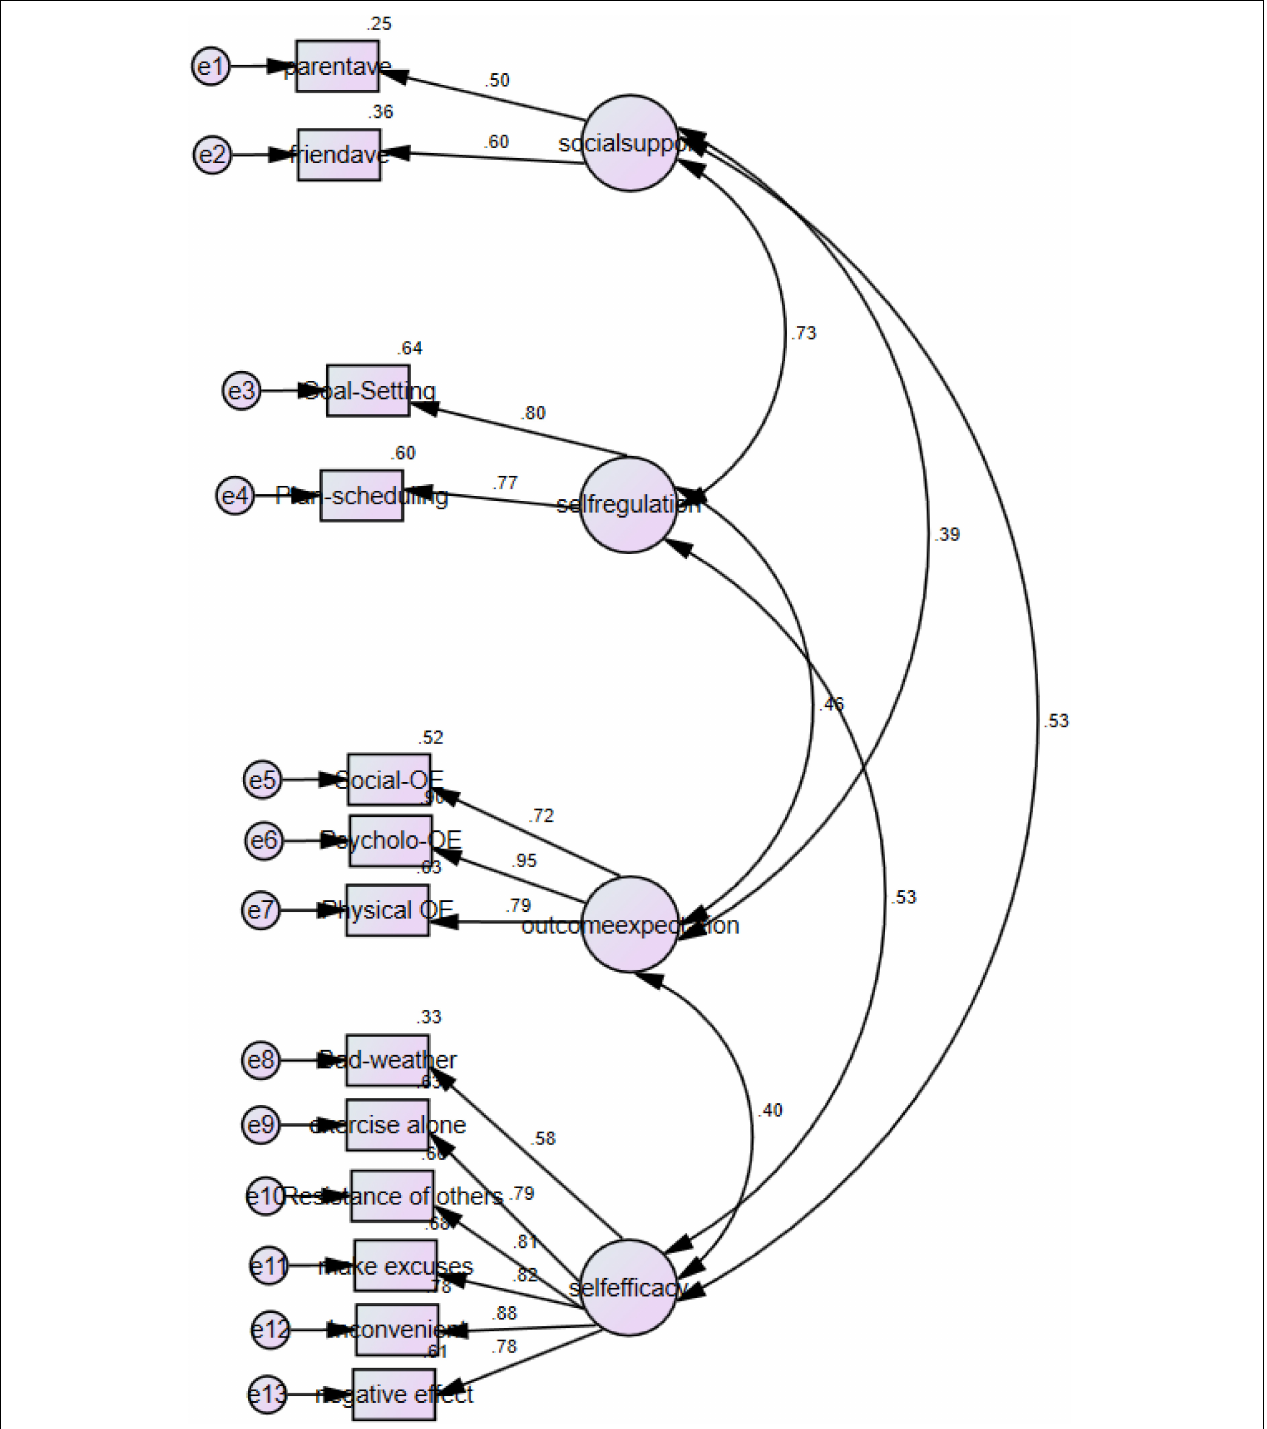
APPENDIX FIGURE 1 | The confirmatory factor analysis (CFA) of the model and the validity of scales in different dimensions.